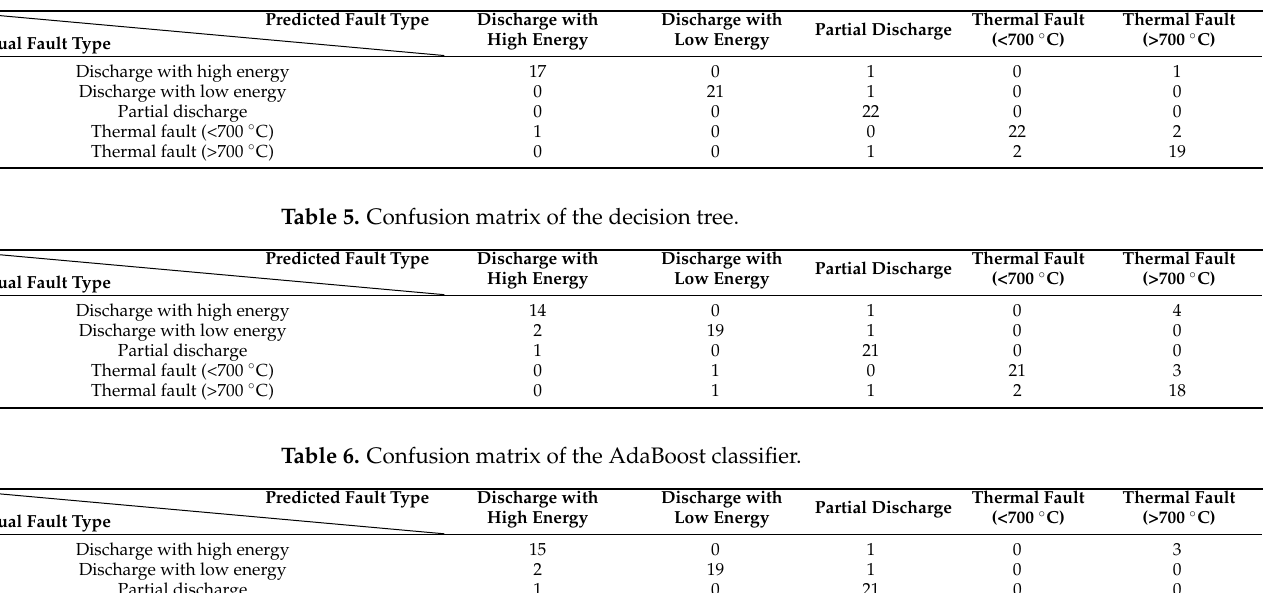
Table 4. Confusion matrix of the random forest classifier.